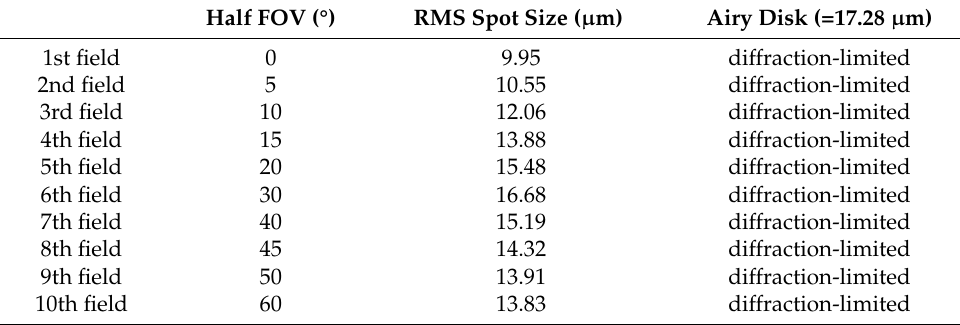
Table 2. RMS spot sizes for all fields, considering the superposition of all